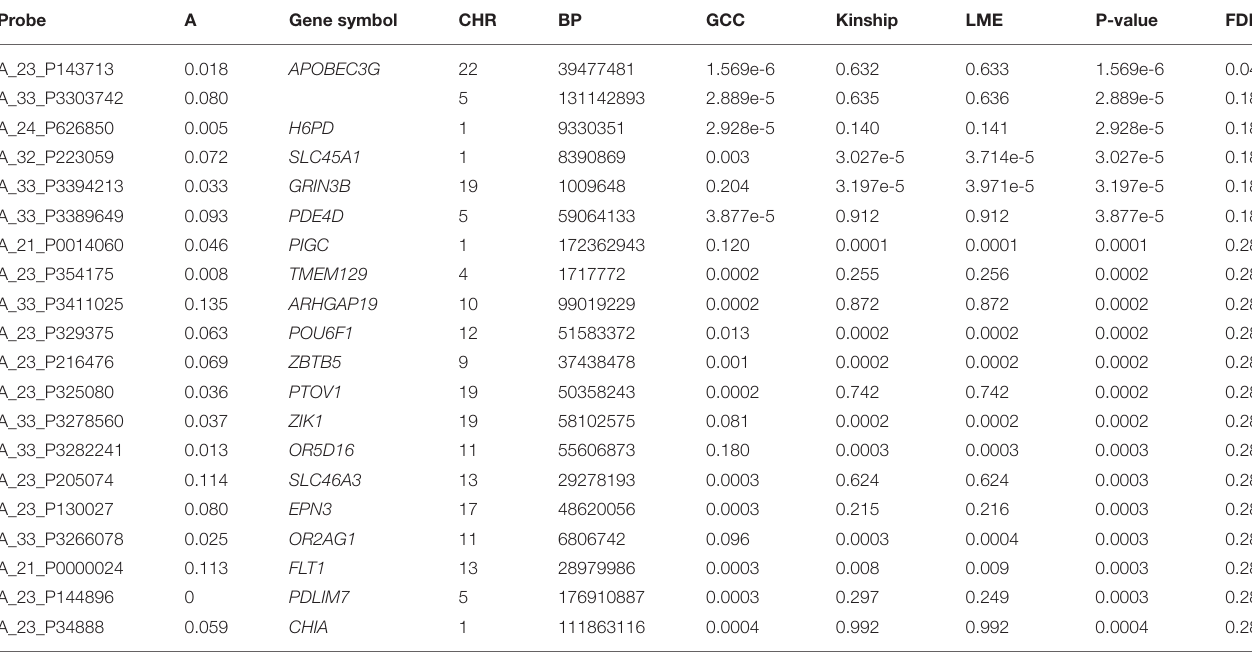
TABLE 1 | List of top 20 mRNA probes from the single mRNA probe